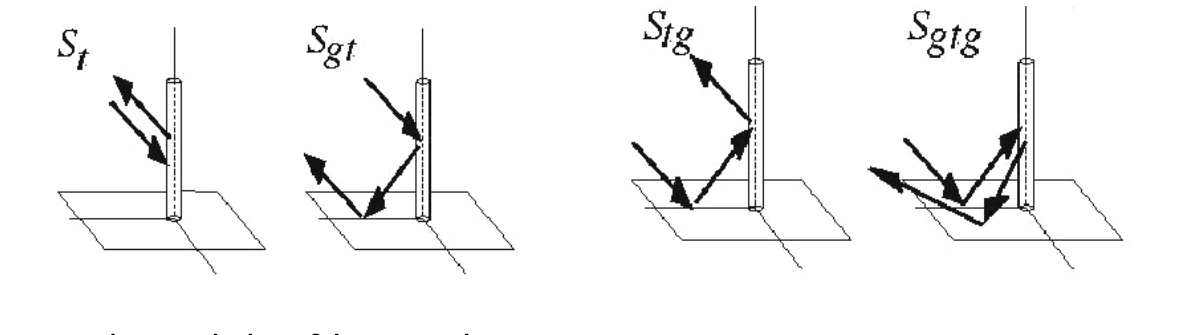
Figure 2. Four contributions to the scattered fields considered in the model. From left to right: trunk-trunk, trunk-ground, ground-trunk, and ground-truck-ground.